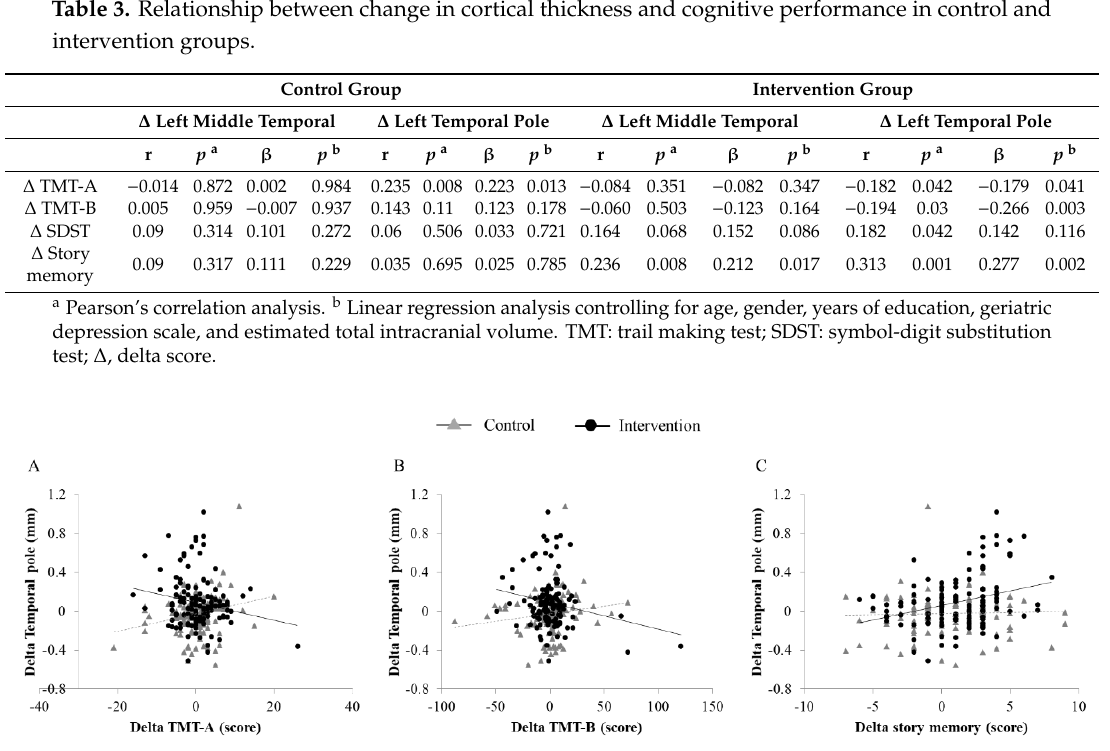
Figure 2. Relationship between changes in cortical thickness of the left temporal pole and cognitive performance: The change in thickness in the left temporal pole is plotted against change in cognitive performance ( A ) TMT-A, ( B ) TMT-B, and ( C ) story memory. Observations from the control group are triangles, and the regression line is dashed. Observation from the intervention group are circles, and the regression line is linear. TMT: trail making test.